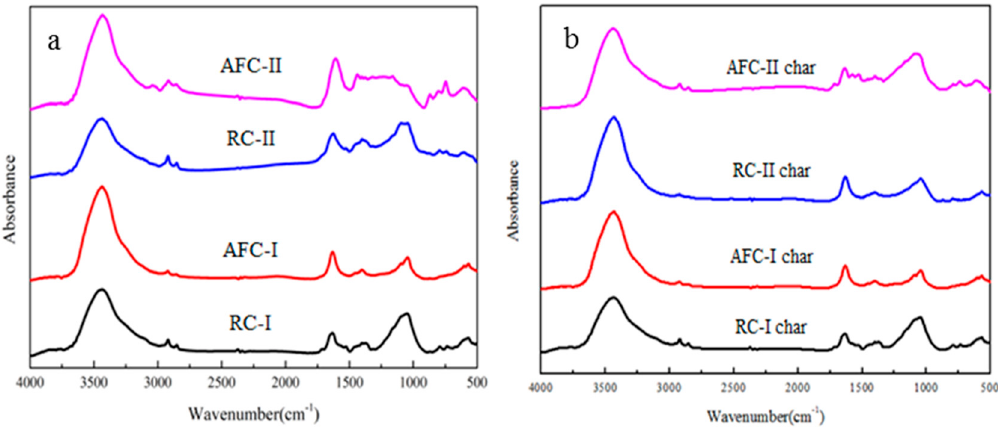
Figure 6. FTIR spectra of the selected samples (( a ): raw coals, ( b ): chars).